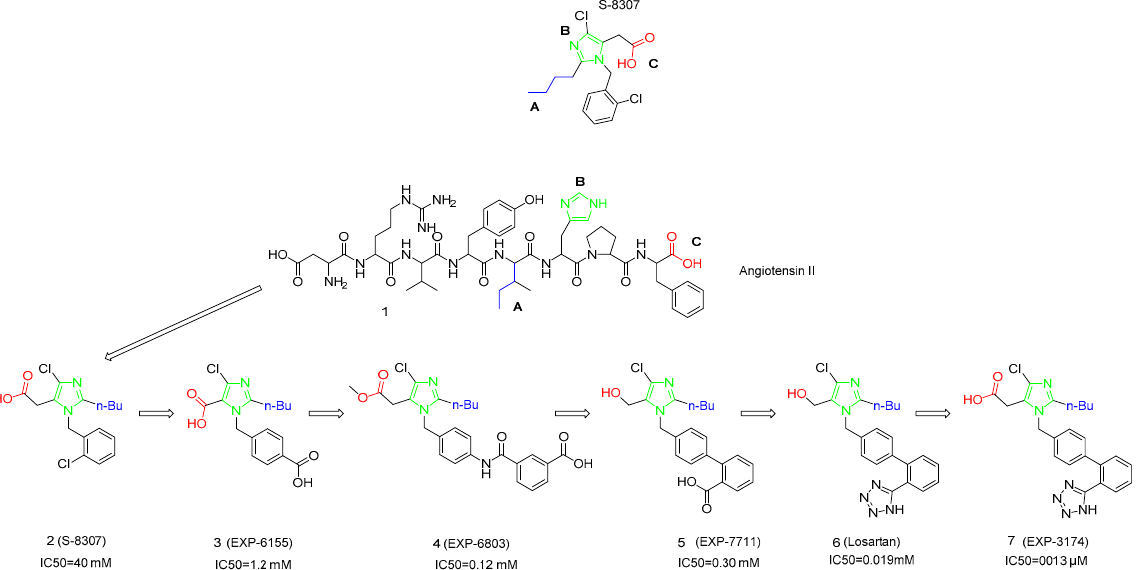
Figure 1. Design efforts that led to the development of losartan.